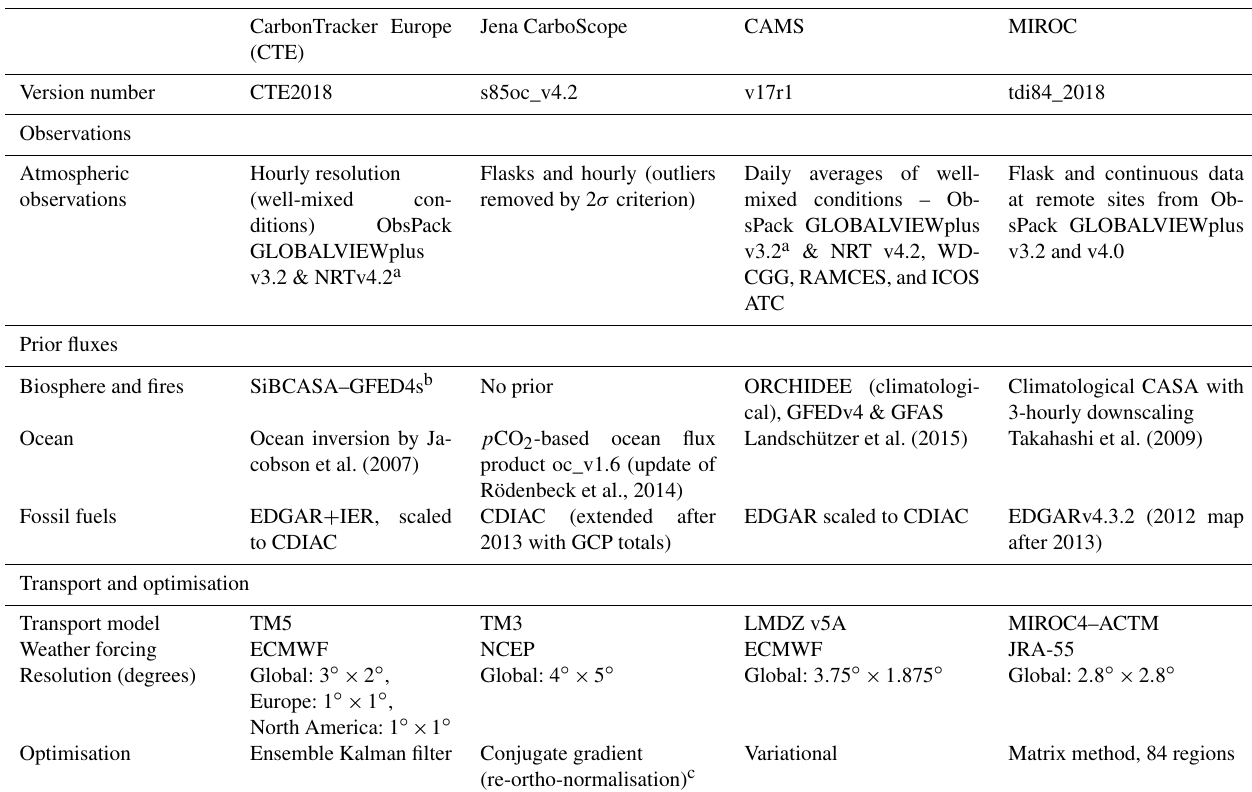
Table A3. Comparison of the inversion set-up and input fields for the atmospheric inversions. Atmospheric inversions see the full CO 2 fluxes, including the anthropogenic and pre-industrial fluxes. Hence they need to be adjusted for the pre-industrial flux of CO 2 from the land to the ocean that is part of the natural carbon cycle before they can be compared with S OCEAN and S LAND from process models. See Table 4 for